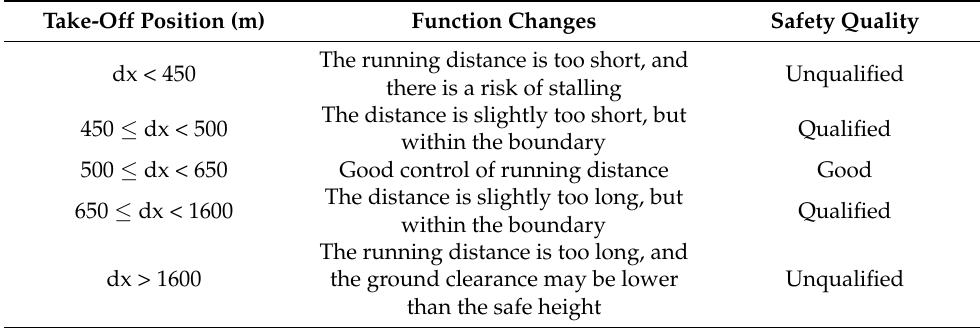
Table 6. Range of throttle function changes.